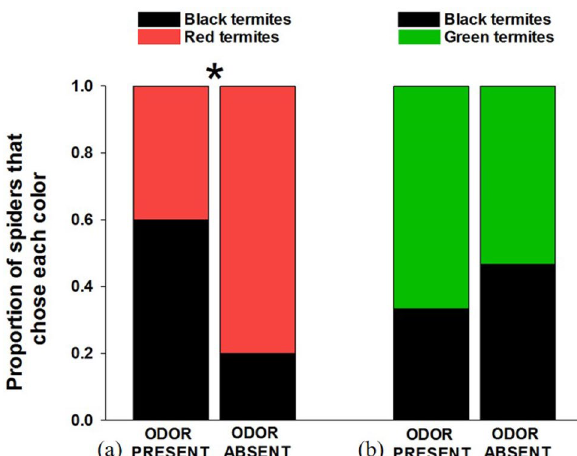
Figure 2. Results of choice tests between ( a ) red- and black-painted termites, and ( b ) green- and black-painted termites in the presence or absence of a defensive odor from eastern leaf-footed bugs ( Leptoglossus phyllopus)